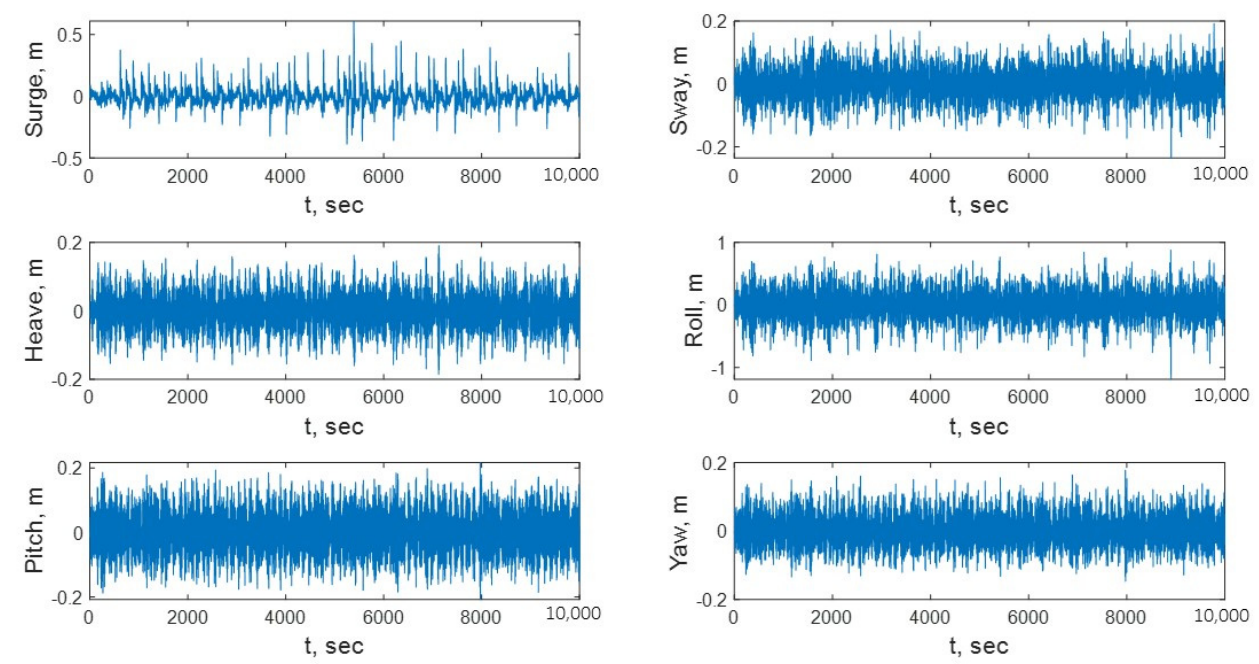
Figure A5. Load case s1 (H mo = 2 m)—wave frequency position. The surge and sway positions are relative to the position of the Delta, the other positions are absolute position of the ship.